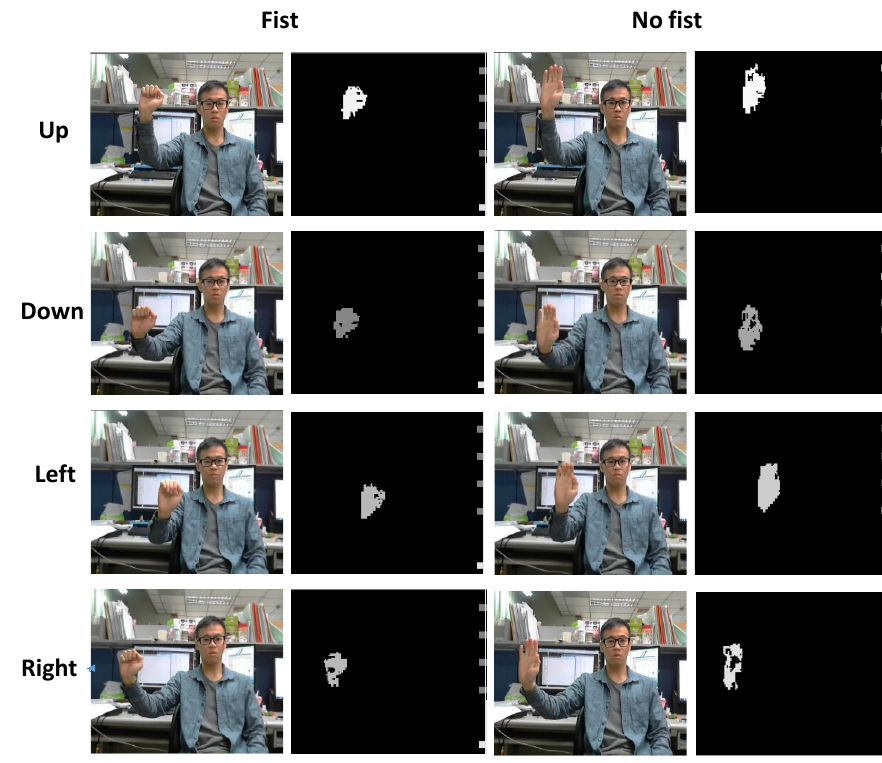
Figure 10. Four directional gesture results.